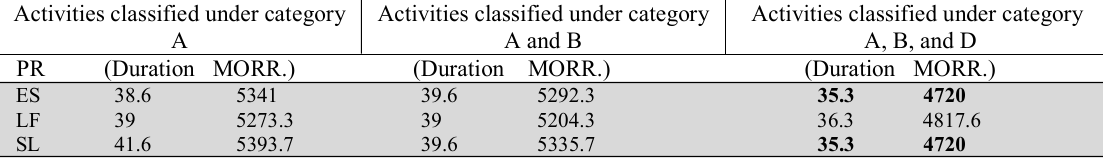
The value of the average duration and MORR for cases 1, 2, and 3. Activities classified under